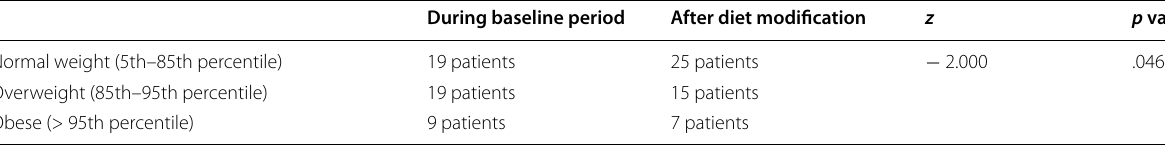
Table 2 BMI interpretation during baseline period and after diet modification program